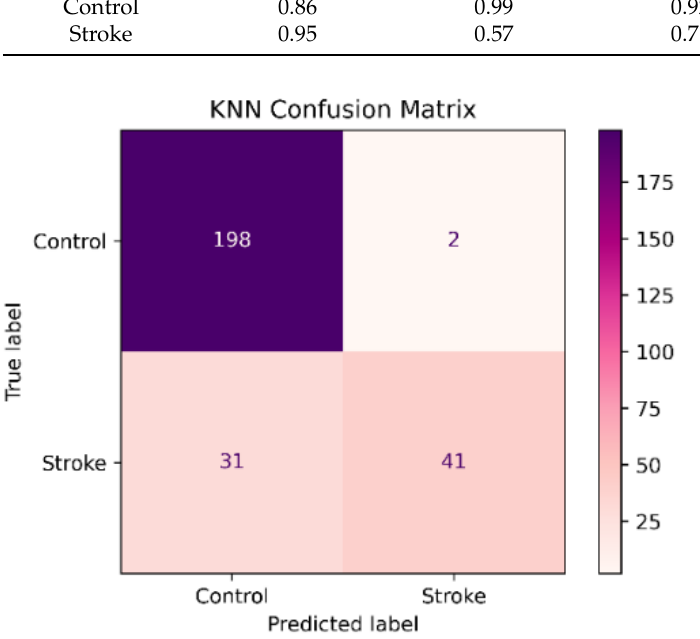
Table 5. Support Vector Machine model classification report.